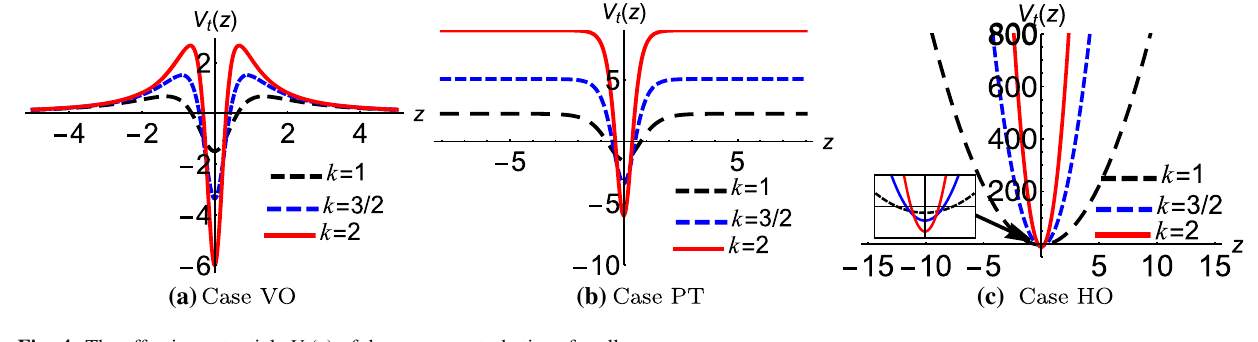
Fig. 4 The effective potentials V t ( z ) of the tensor perturbations for all